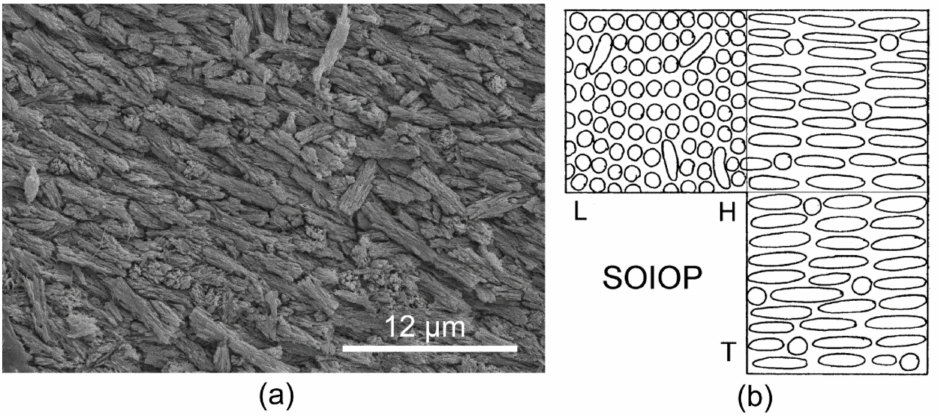
Figure 3. SOIOP structure in the tube of Protula diomedeae . ( a ) Transverse section, polished and etched with acetic acid. ( b ) Schematic line drawing of the SOIOP structure.